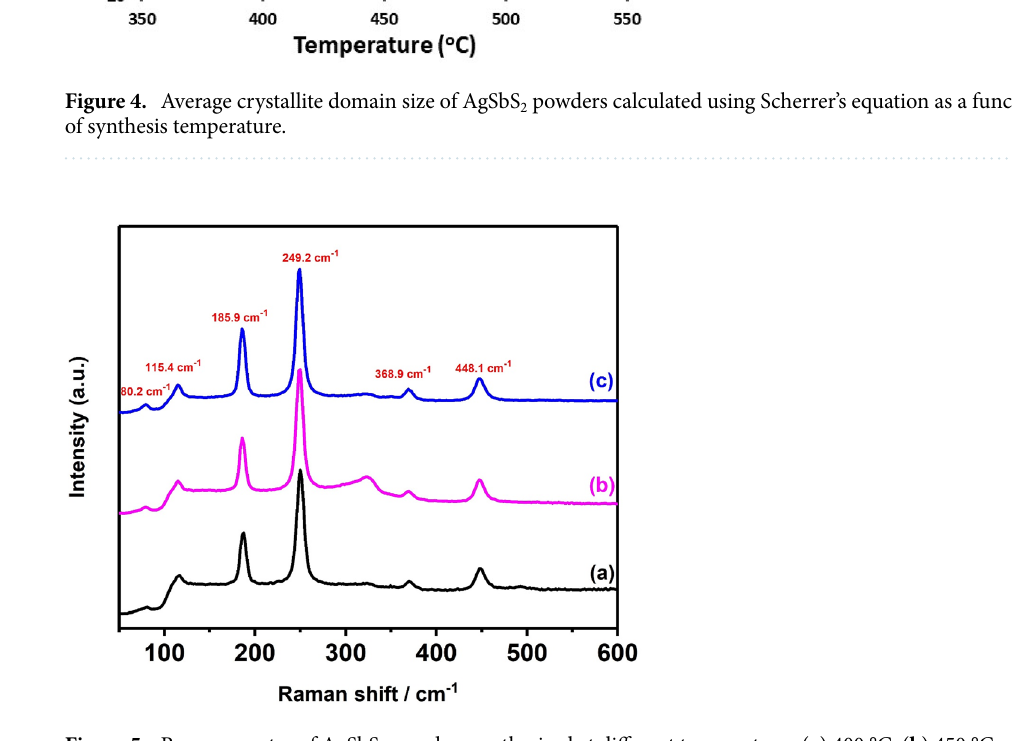
Figure 5. Raman spectra of AgSbS 2 powders synthesised at different temperatures ( a ) 400 °C, ( b ) 450 °C and ( c ) 500 °C for 1 h under